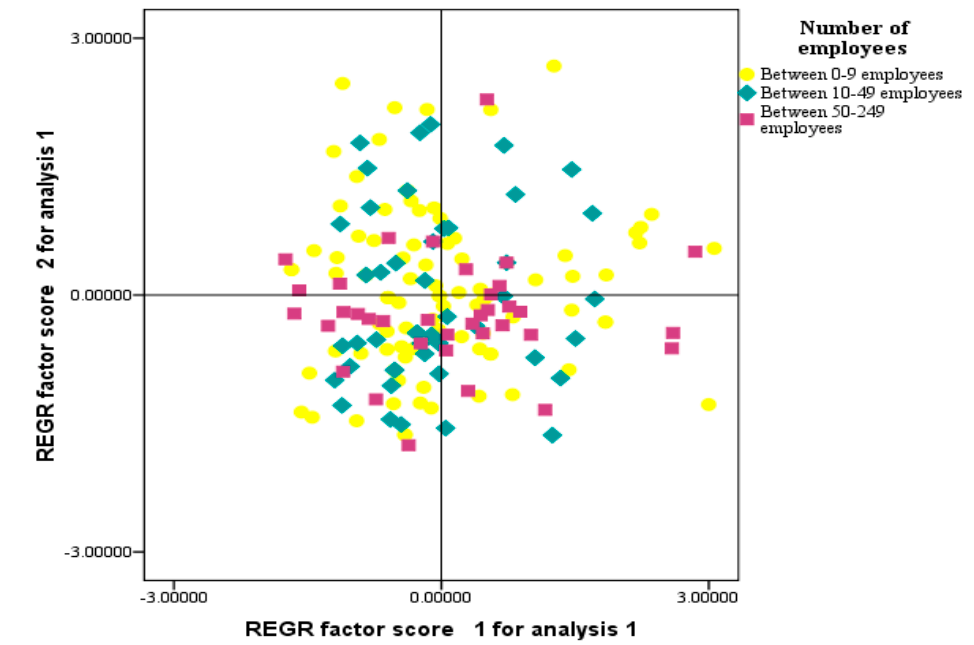
Figure 4. Representation of SMEs by size in the two main components. Table 7. Matrix of correlation coefficients between the 6 variables analyzed.